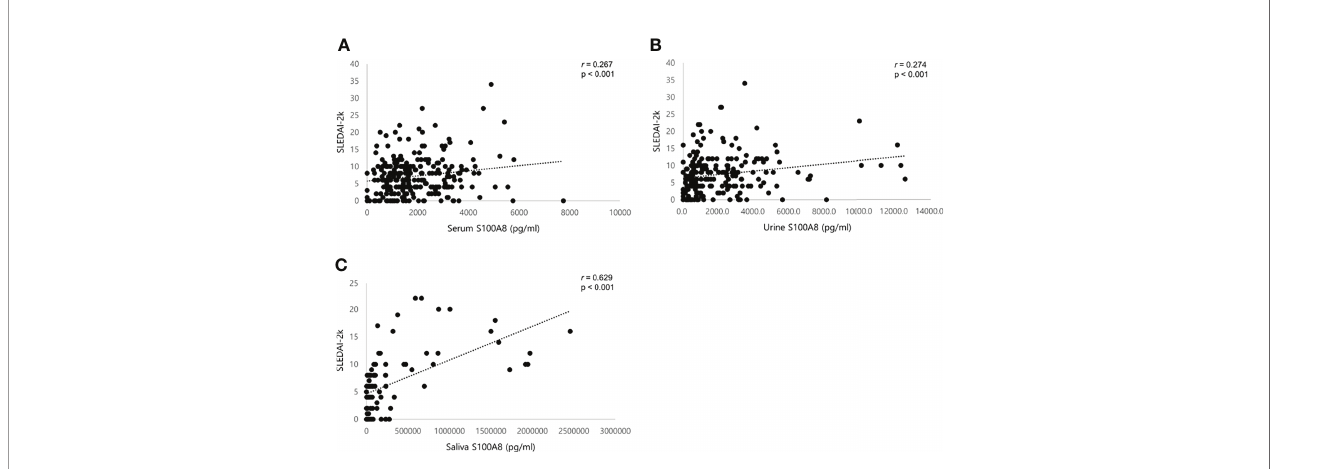
FIGURE 3 | Scatter plots showing positive correlations between S100A8 and SLEDAI-2K in patients with SLE. (A) Serum S100A8. (B) Urine S100A8. (C) Salivary S100A8. SLEDAI, systemic lupus erythematosus (SLE) disease activity index. Statistical analyses were conducted using Pearson ’ s correlation analyses.